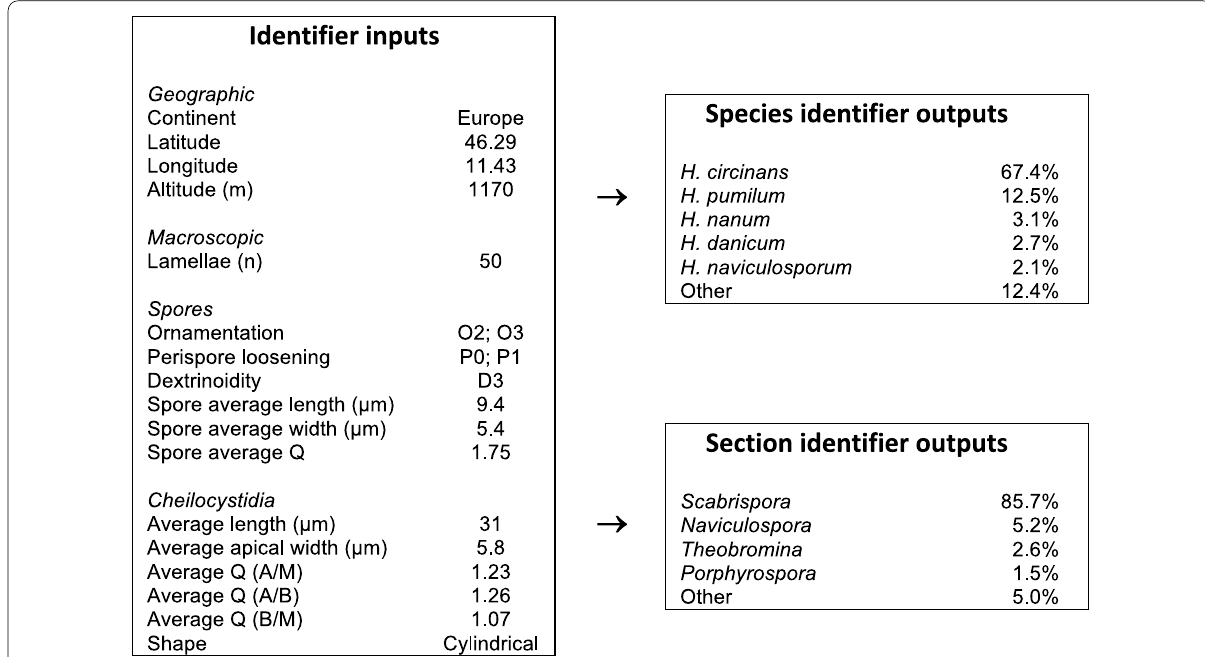
Fig. 2 Representation of the identifier as presented to a user. The user enters inputs on the left-hand side. The identifier computes class probabilities by calculating the same Neutral Network function as during the training phase, but now with fixed ‘learnt’ parameters. The data used here is from collection HJB17396. Expert analysis had assessed this collection to be Hebeloma circinans from H. sect. Scabrispora . Thus, in this case, the top ‘guess’ of the identifier is correct and this result would be included in the “Top 1” metric